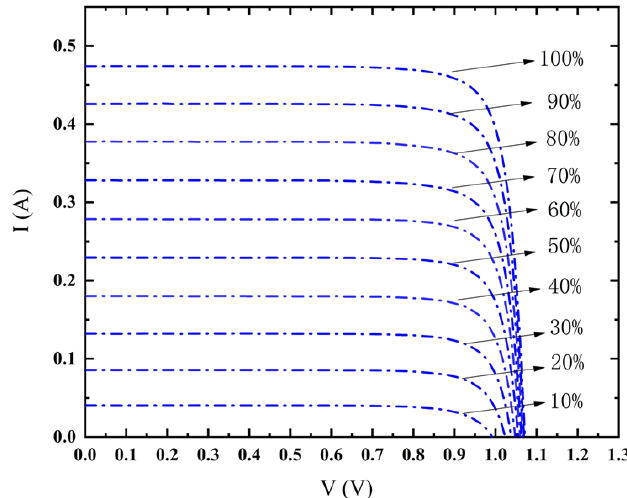
Figure 4. I − V curves under different illumination area percentages.